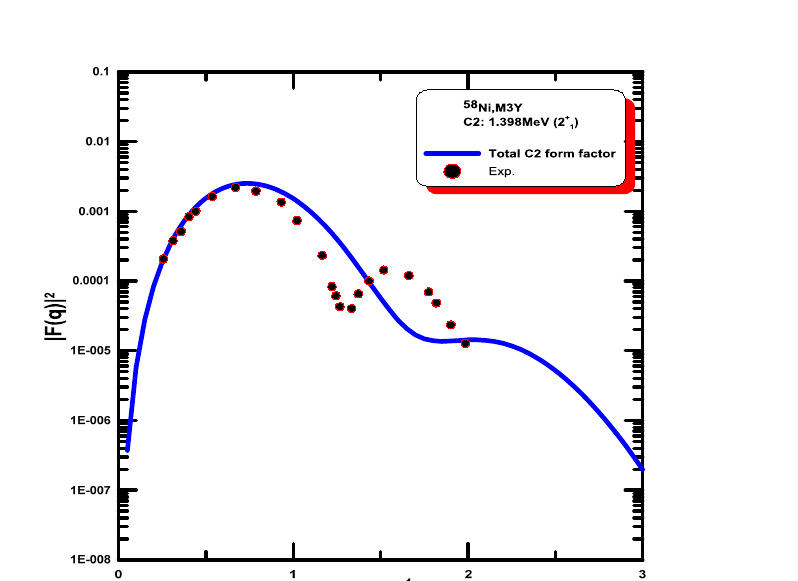
=1.398 MeV) state in x